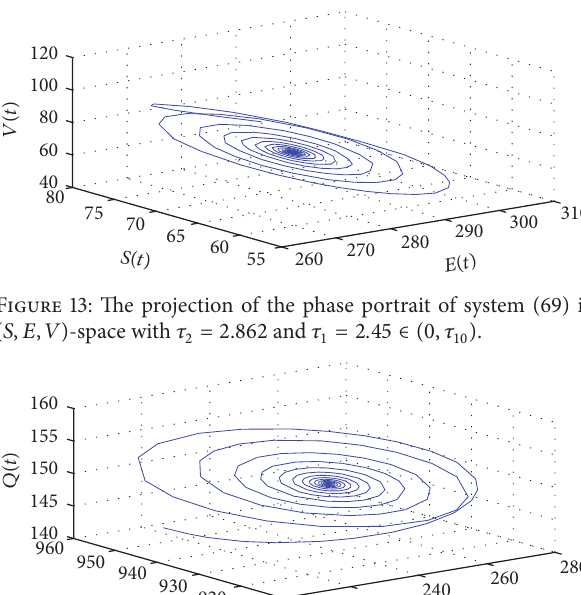
= 2.86 and 𝜏 = 2.25 ∈ (0, 𝜏 ) . 1 2 20